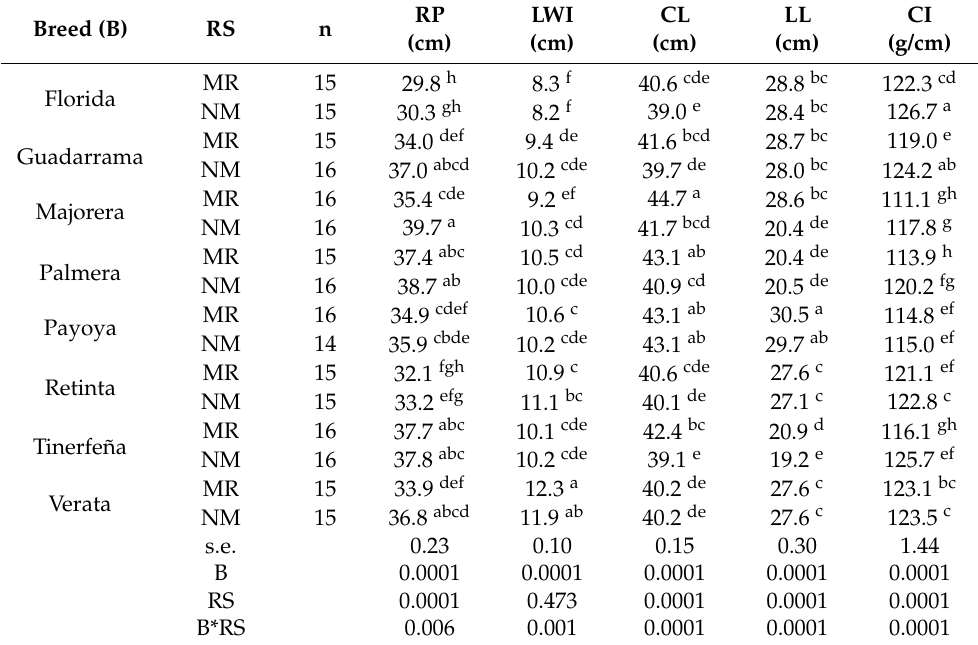
Table 2. Carcass measurements of kids reared with milk replacer (MR) or natural milk from their dams